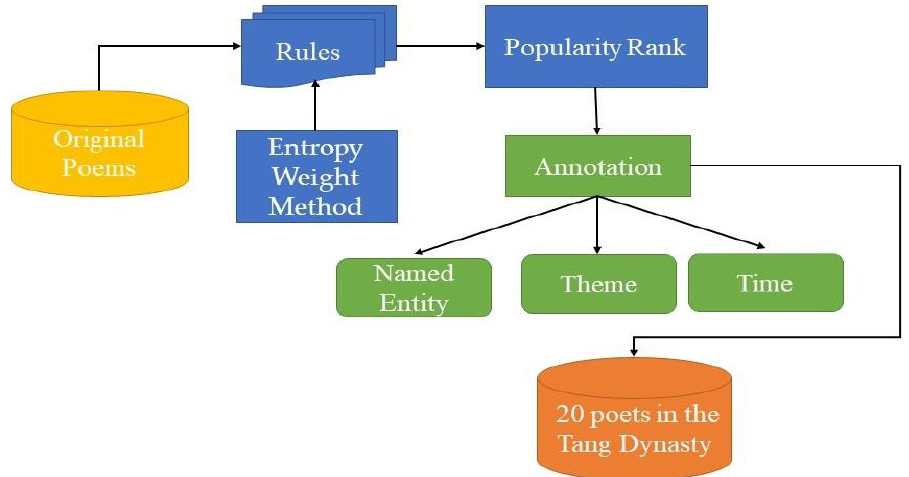
Figure 1. The overall view of the data collection process.